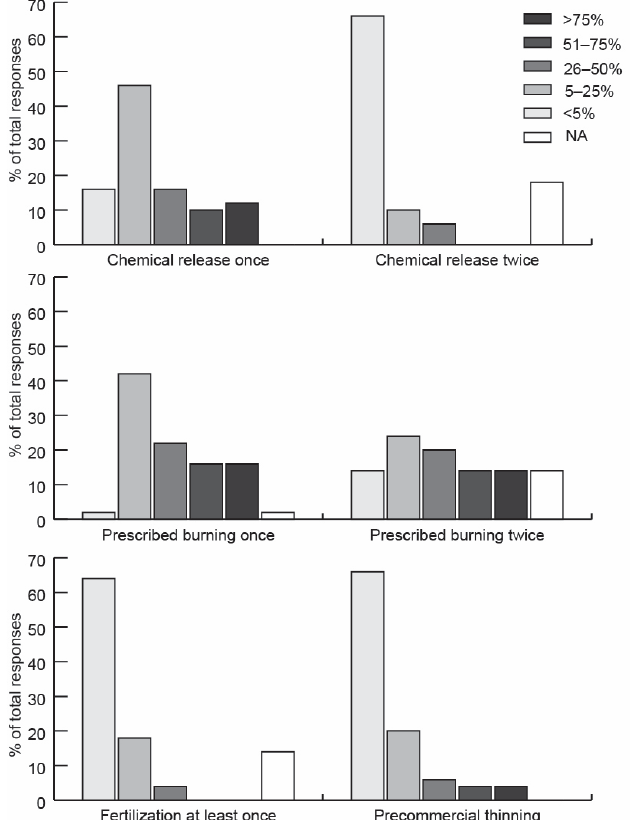
Figure 3. The survey respondents’ reported mid ‐ rotation forest management practices conducted in pine stands in Georgia.